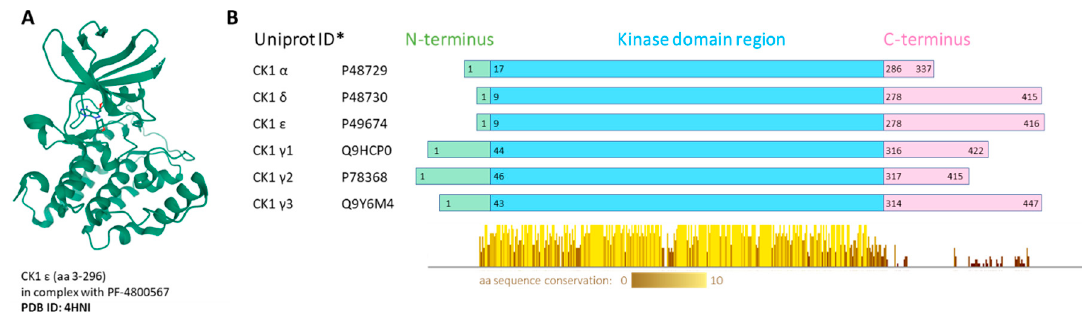
Figure 1. ( A ) Visualization of human CK1 ε crystal structure in complex with PF-4800567 bound in the adenosine triphosphate (ATP)-binding pocket. The structure screenshot is based on the PDB 4HNI [10] entry from the RCSB PDB (rcsb.org) [11]. ( B ) Conserved regions visualization. Multiple alignment was produced by ClustalOmega, the conserved regions present in the kinase domain were visualized by Jalview 2.11.0. * Canonical variant; aa—amino acid.